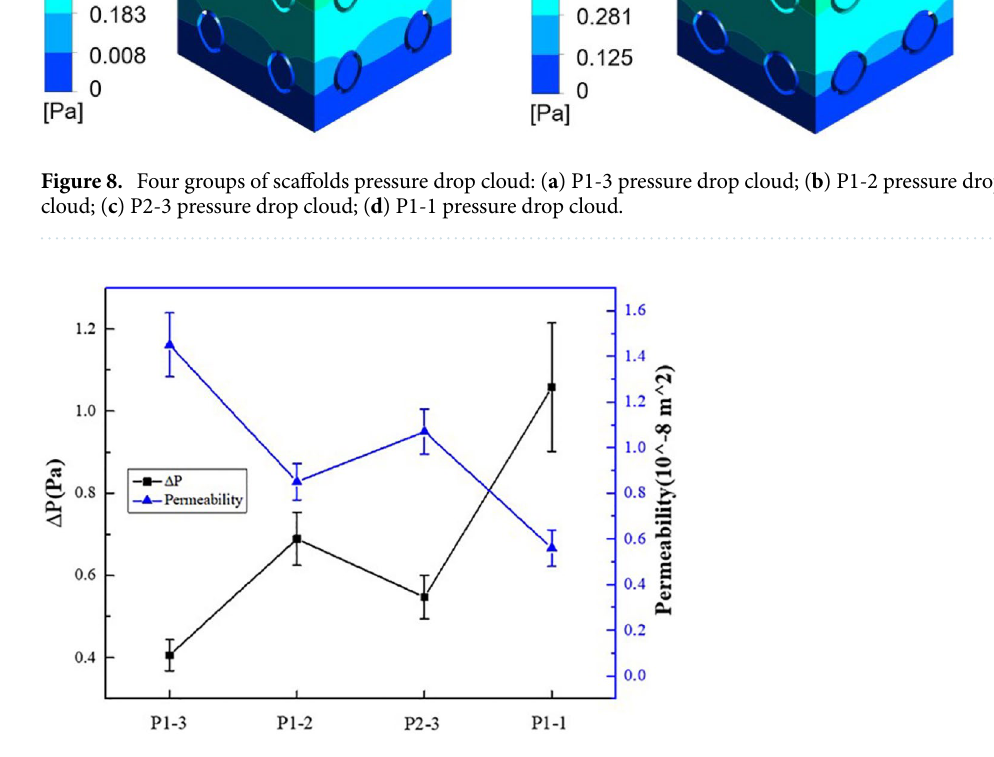
Figure 9. Pressure drop and permeability of four groups of